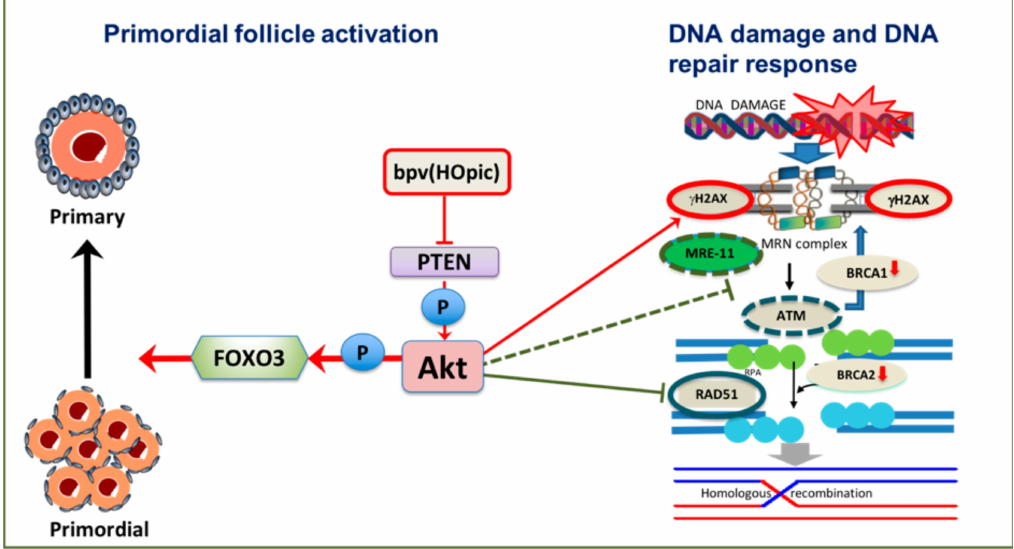
Figure 4. Potential e ff ects of phosphoinositide 3-kinase / protein kinase B (PI3K / Akt) activation on DNA damage and DNA repair response of oocytes in vitro. Inhibition of PTEN by low dose Dipotassium bisperoxo(5-hydroxypyridine-2-carboxyl) oxovanadate (V) (bpv(HOpic)) is su ffi cient to induce primordial follicle activation. However, gamma H2AX ( γ H2AX) increases and DNA repair proteins meiotic recombination 11 (MRE11), ataxia telangiectasia mutated (ATM) and Rad51 are downregulated, as are breast cancer susceptibility gene 1 ( BRCA1 ) and breast cancer susceptibility gene 2 ( BRCA2